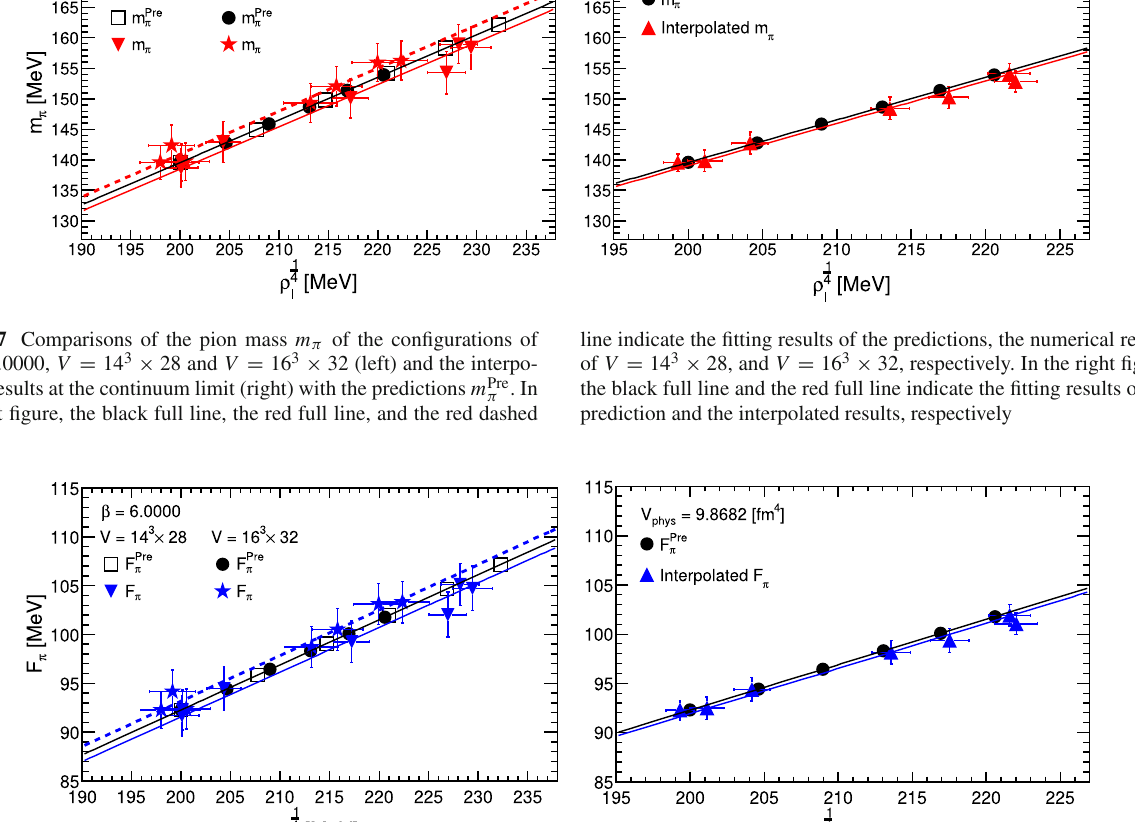
Fig. 18 Comparisons of the pion decay constant F π of the configura- tions of β = 6 . 0000, V = 14 3 × 28 and V = 16 3 × 32 (left) and the interpolated results at the continuum limit (right) with the predictions F Pre π . In the left figure, the black full, the blue full, and the blue dashed